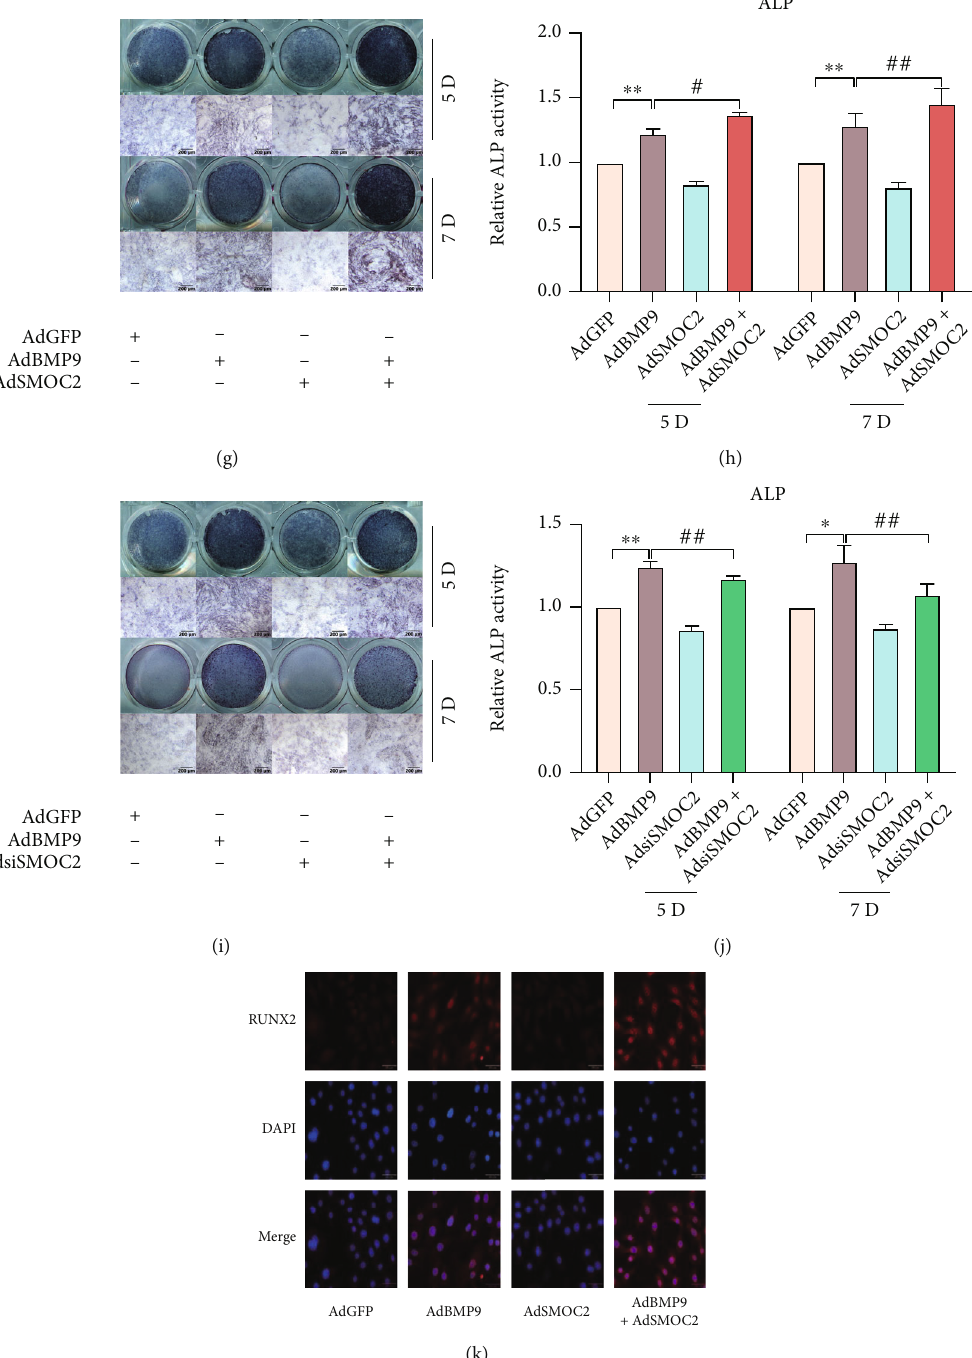
Figure 2: The e ff ect of SMOC2 on BMP9-induced early osteogenic marker levels. (a) Real-time PCR assay results showed the e ff ect of SMOC2 on the mRNA expression of RUNX2 induced by BMP9. (b) Western blot results showed the e ff ect of SMOC2 on the protein expression of RUNX2 induced by BMP9 at 24h and 48h. (c) The quanti fi cation results of the Western blot results showed the e ff ect of SMOC2 on the protein expression of RUNX2 induced by BMP9. (d) Real-time PCR assay results showed the e ff ect of SMOC2 knockdown on the mRNA expression of RUNX2 induced by BMP9. (e – f) Western blot assay and quanti fi cation results showed the e ff ect of SMOC2 knockdown on the protein expression of RUNX2 induced by BMP9 at 24 h and 48 h. (g – h) ALP assay and quanti fi cation results showed the e ff ect of overexpression or knockdown of SMOC2 on the activity of ALP induced by BMP9 in MEFs. (k) Immuno fl uorescence staining assay results showed the e ff ect of SMOC2 on the expression of RUNX2 induced by BMP9. Compared with the control group, ∗ p < 0 : 05 ; ∗∗ p < 0 : 01 ; compared with the AdBMP9 group, # p < 0 : 05 , ## p < 0 : 01